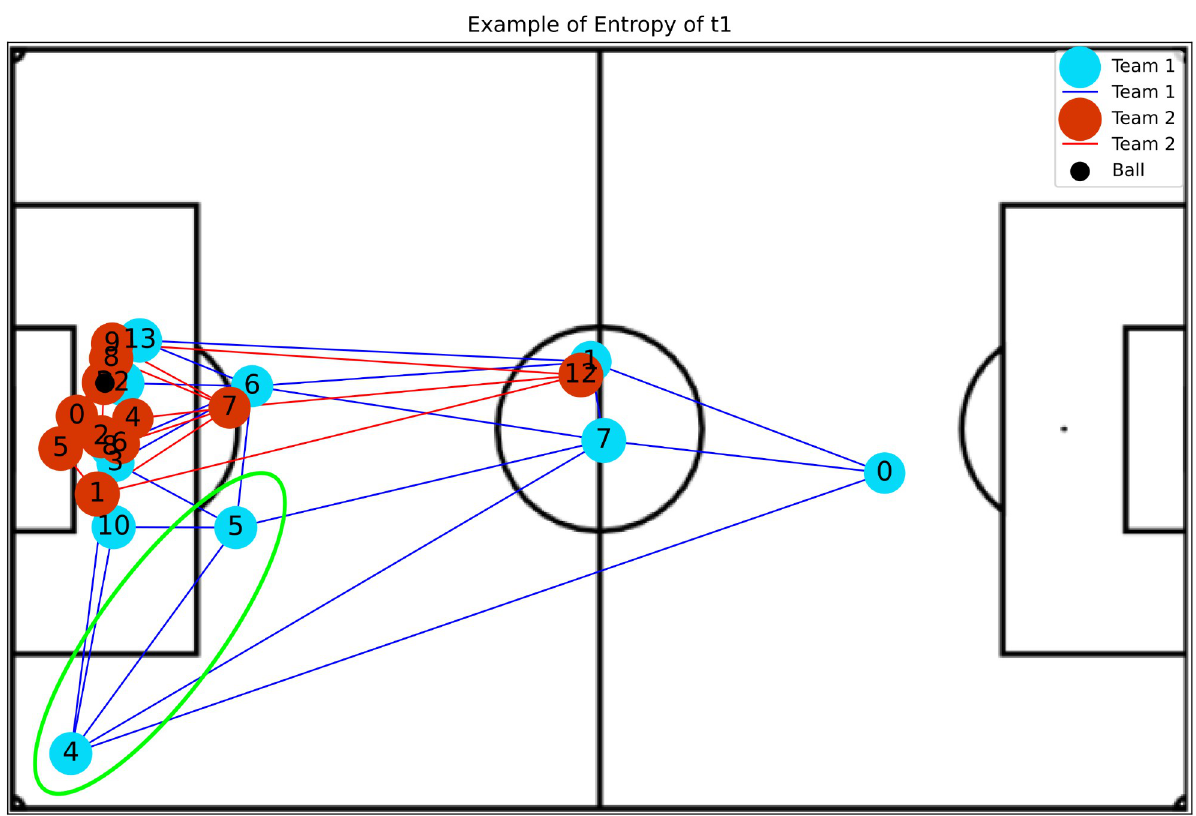
Fig 6. The image illustrates a high entropy situation for team t1 (with ball possession), where it is possible to observe that players 5 and 4 (the region highlighted in green in the figure) are free of marking and with several options of passes (edges incident on the vertex), thus having a greater chance of receiving